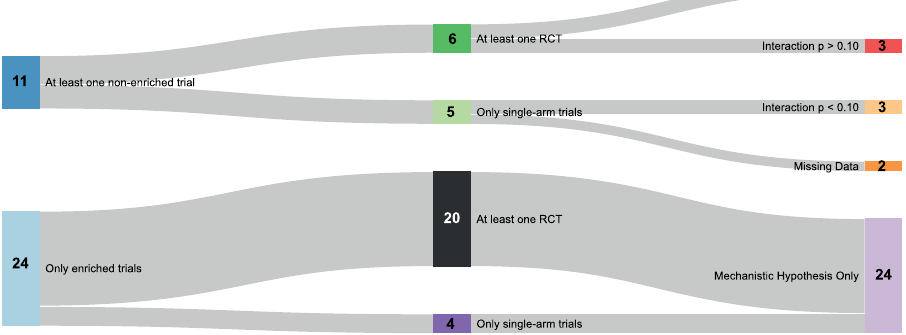
Figure 2. Sankey diagram representing the distribution of FDA drug approvals for which all trials included biomarker-positive patients (ie, enriched), the number of approvals with at least one non-enriched randomized controlled trial and the statistical significance of the treatment-by-biomarker interaction. Width of links is proportional to the number of